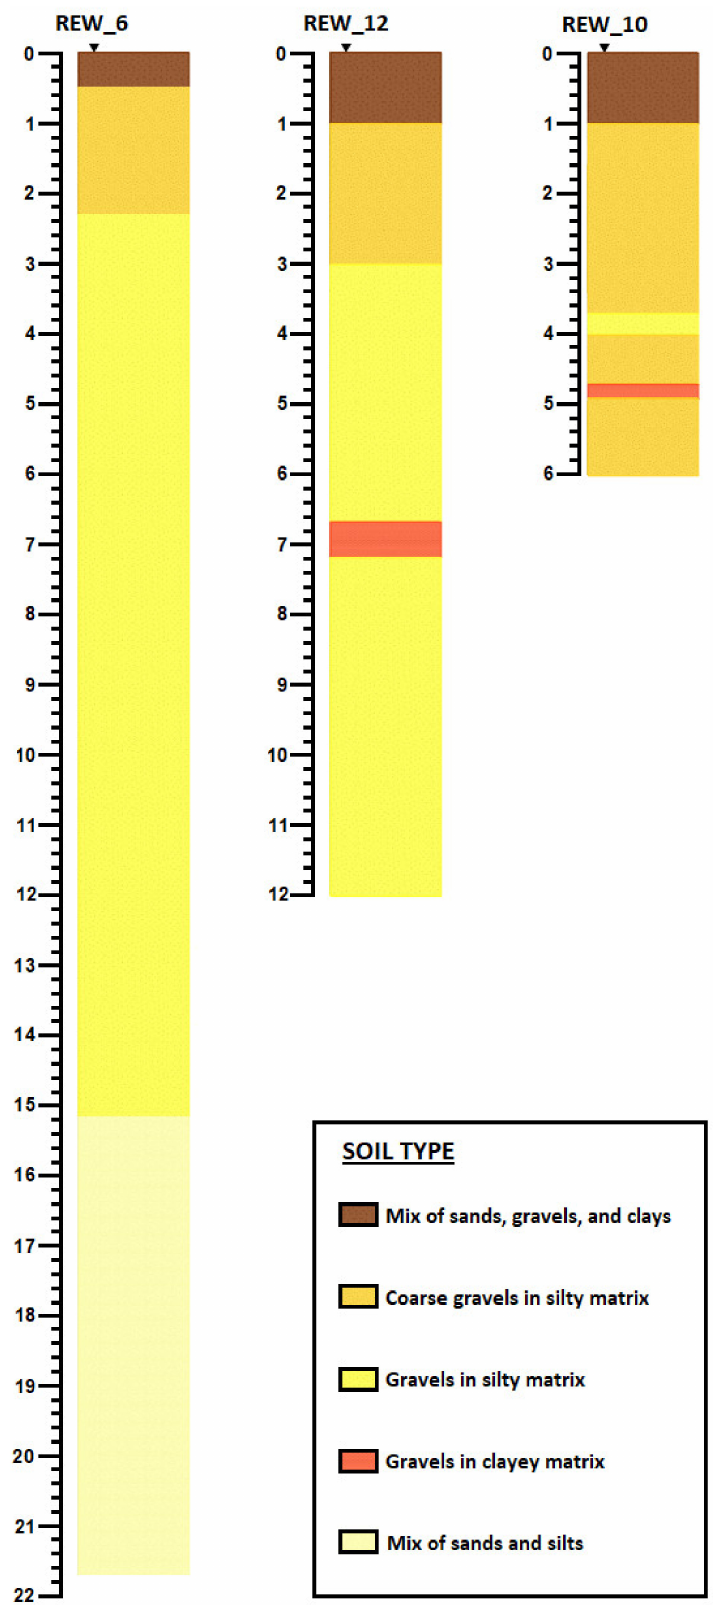
Figure 2. Stratigraphy of three piezometers near the infiltration basin. Information obtained from the analysis of the soil cores during the construction of these